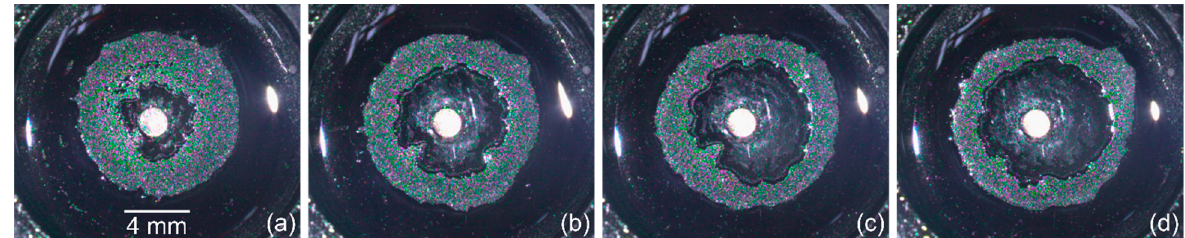
Figure 6. Optical images (top view) of the ring deposits of microparticles obtained at different cooling time spans and the corresponding values of ∆𝑇 on the rod for 𝑃 = 1.2 W: ( a ) 5 s, − 3.1 °C; ( b ) 10 s, − 4.7 °C; ( c ) 15 s, − 6.1 °C; ( d ) 50 s, − 9 °C.